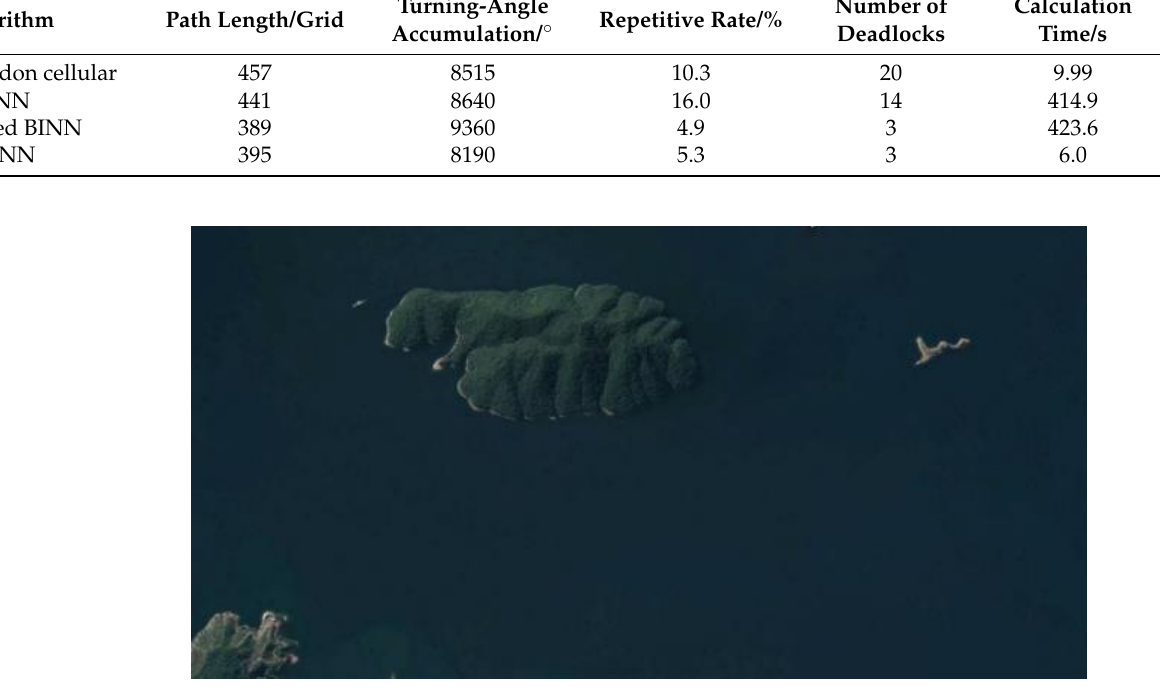
Figure 13. The real-world